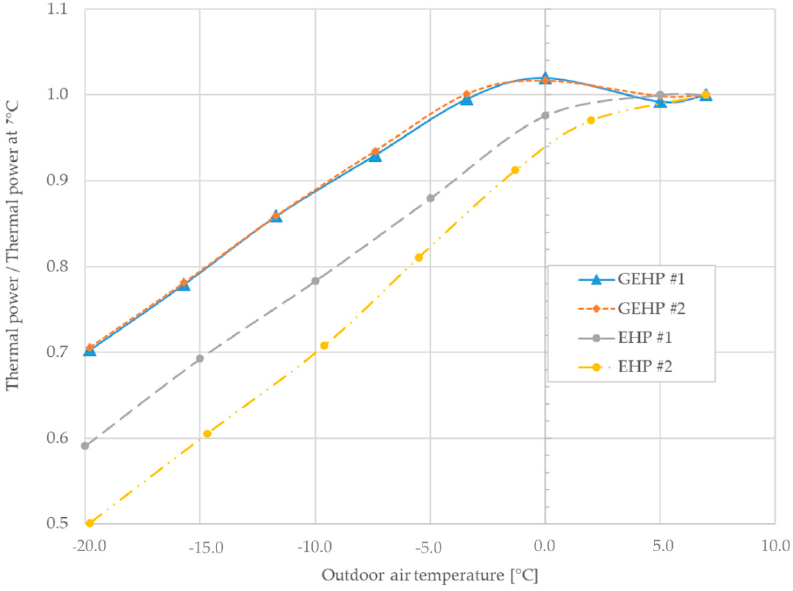
Figure 4. Ratio between thermal power and thermal power delivered at 7 °C, as a function of outdoor air-dry bulb tem- perature (indoor air temperature is fixed to 20 °C) for GEHP #1 [23], GEHP #2 [23], EHP #1 [24] and EHP #2 [25]. The main disadvantages of a GEHP in comparison to an EHP are: